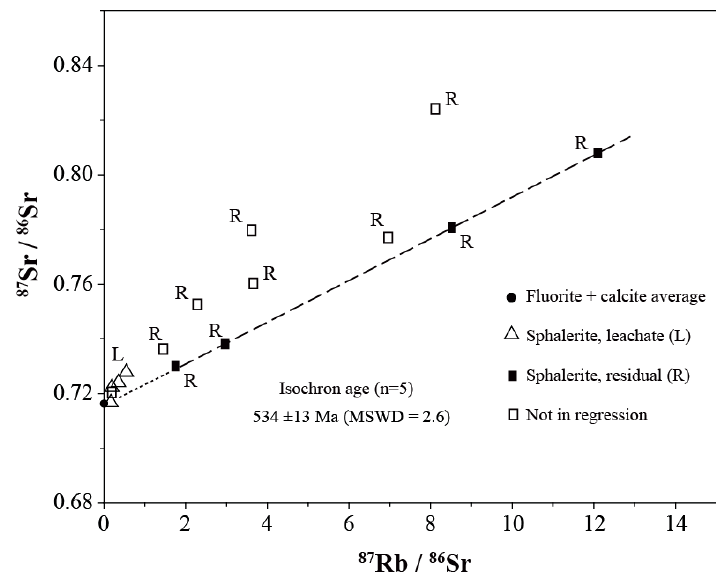
Figure 16 . Rb-Sr data for the sphalerite samples used for dating the fracture-controlled Zn-Pb deposits. Also shown are data for gangue minerals.